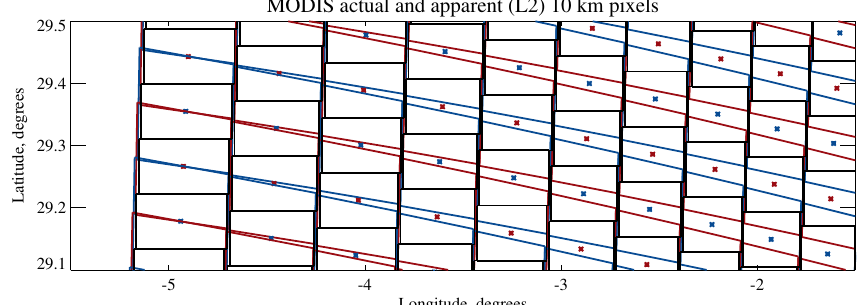
Figure 5. Borders of nominal 10km retrieval pixels (strong colours, as in Fig. 4c) along the western edge of the granule shown in Fig. 2. Pixel centres are overplotted with coloured asterisks, and inferred L2 pixel bounds are drawn in black lines.